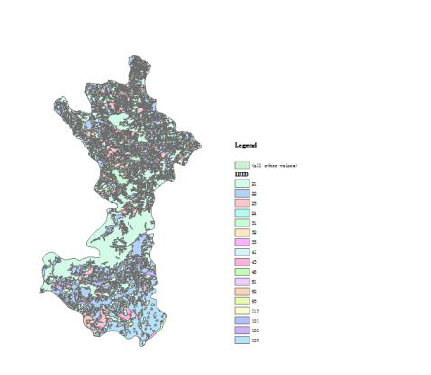
Figure4 ： Land-use and Land-cover of Huairou in